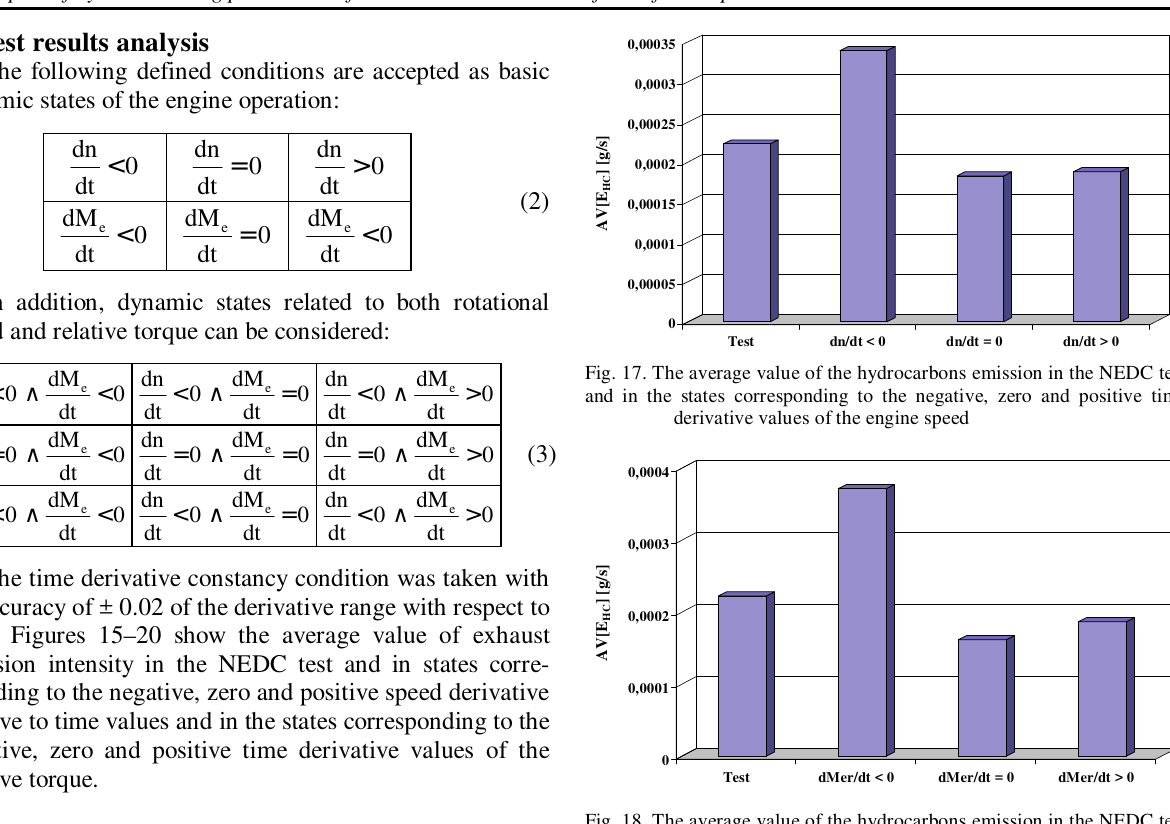
Fig. 18. The average value of the hydrocarbons emission in the NEDC test and in the states corresponding to the negative, zero and positive time derivative values of the engine torque